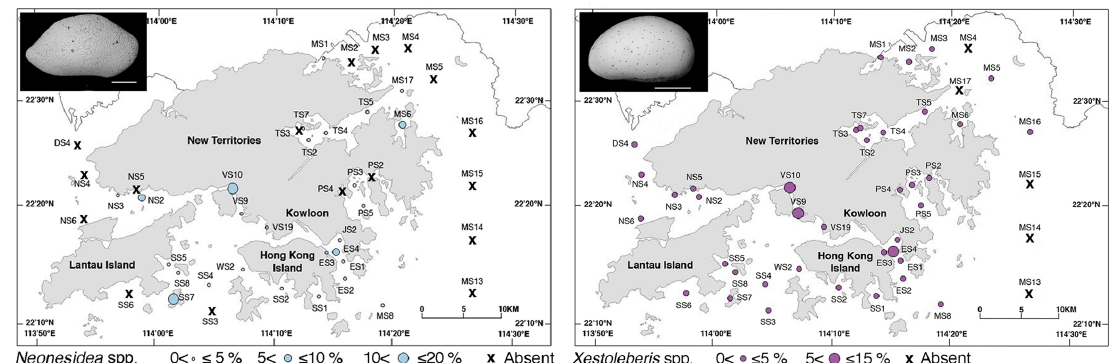
Figure 7. Spatial distribution of the relative abundance for Neonesidea spp. and Xestoleberis spp. in Hong Kong. The scale bar is 200µm. Table 5. Summary of autoecology for common ostracod taxa. Chl: chlorophyll a ; D: water depth; DO: dissolved oxygen; MD: mud content; Sal: salinity; Tur: turbidity; WT: winter temperature; Pb: lead; Zn: zinc; R: region. The + and − marks indicate significant positive and negative correlations,